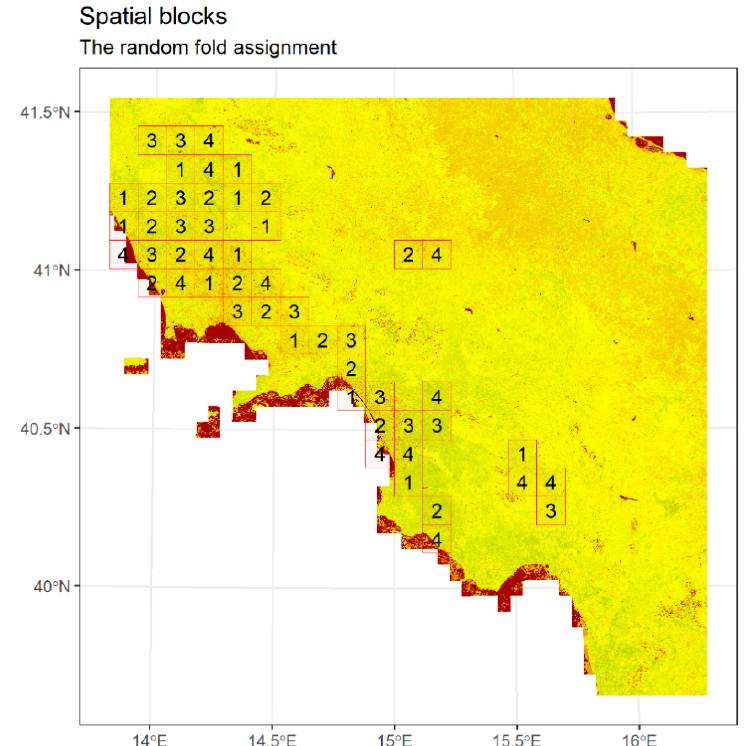
Figure 15. Partition of the region in spatially disjoint blocks (with size of 10,000 m) and their random assignment to four folds. This was accomplished using the R package blockCV [47].